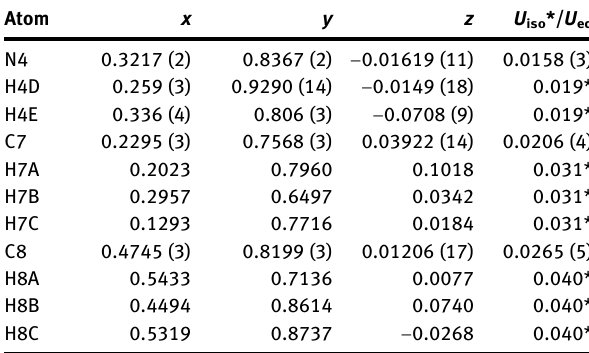
Table  : Fractional atomic coordinates and isotropic or equivalent isotropic displacement parameters (Å 